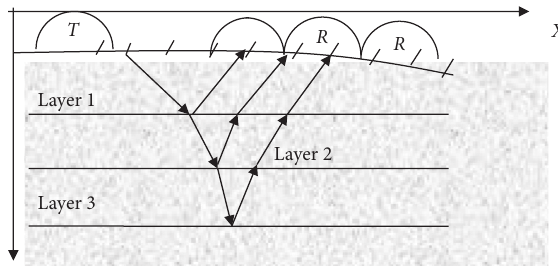
Figure 1: Flowchart of a typical ground-penetrating radar